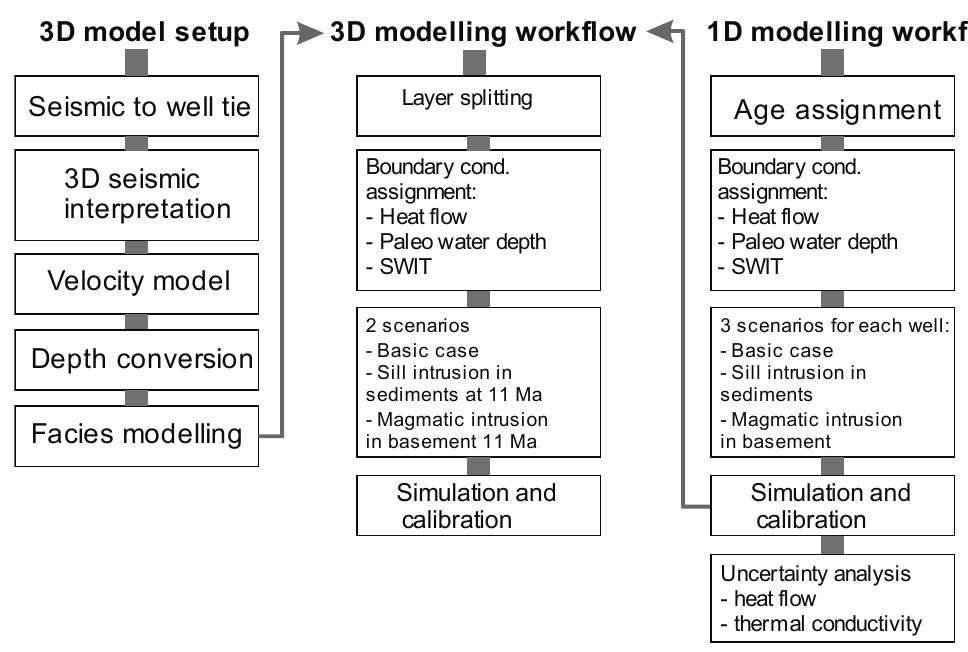
Figure 4. Workflow for 3D models setup and petroleum system modeling.